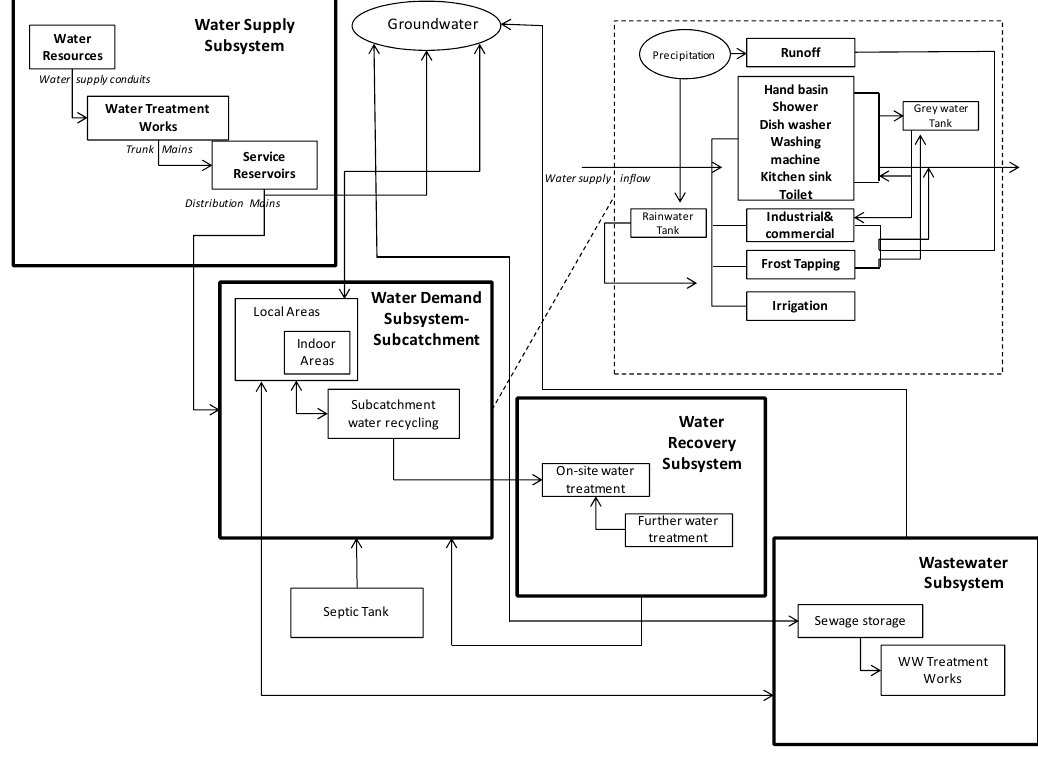
Figure 1. Components used for modelling different spatial levels in WaterMet 2 .